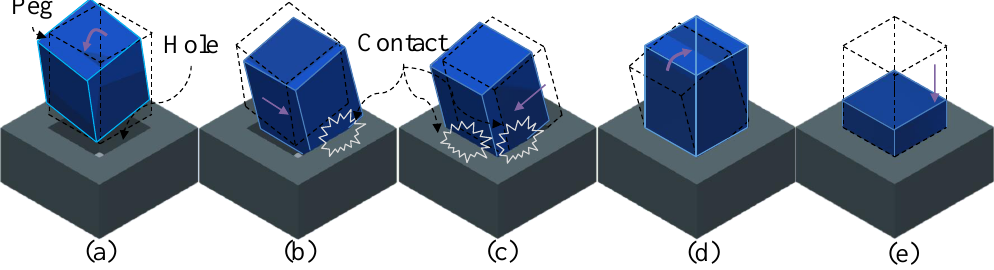
Figure 2. “Hole search” and “peg insertion” motions in the peg-in-hole task: ( a ) tilt-search motion; ( b ) single-point contact motion, which pushes on one face of the peg to make contact with the hole; ( c ) two-point contact motion, which pushes two faces of the peg to make contact with the hole; ( d ) tilting motion to align that the peg and hole; and ( e ) pushing motion to push the peg down into the hole.